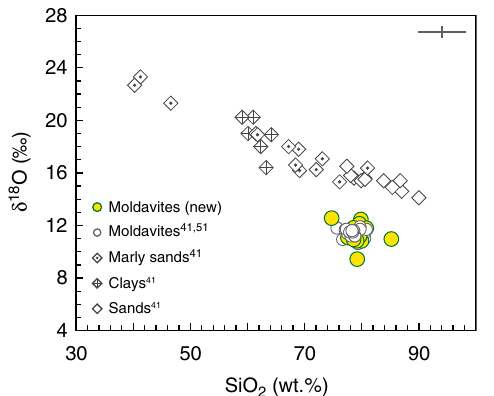
Fig. 2 New and published δ 18 O values vs. SiO 2 contents in moldavites and sediments from the Ries area. The wider range in δ 18 O values of moldavites from this study is due to analyzing chemically more variable specimens 29 compared to those analyzed earlier 41, 51 . Silica contents in some earlier analyzed moldavites 51 were reported elsewhere 83 . Available combined SiO 2 – δ 18 O data for chemically diverse Ries area sediments 41 are plotted. Clays and marly sands can represent only a small proportion of parental material to moldavites while SiO 2 -rich sands dominate the budget 4, 13, 41 . The consistent δ 18 O offset of ~3 – 5 ‰ between moldavites and possible parental sediments from Ries area appears to be a combination of several aspects, explored in detail in the main text. The maximum 2 s.d. error bars for δ 18 O ( ± 0.4 ‰ ) and SiO 2 ( ± 2%) are plotted